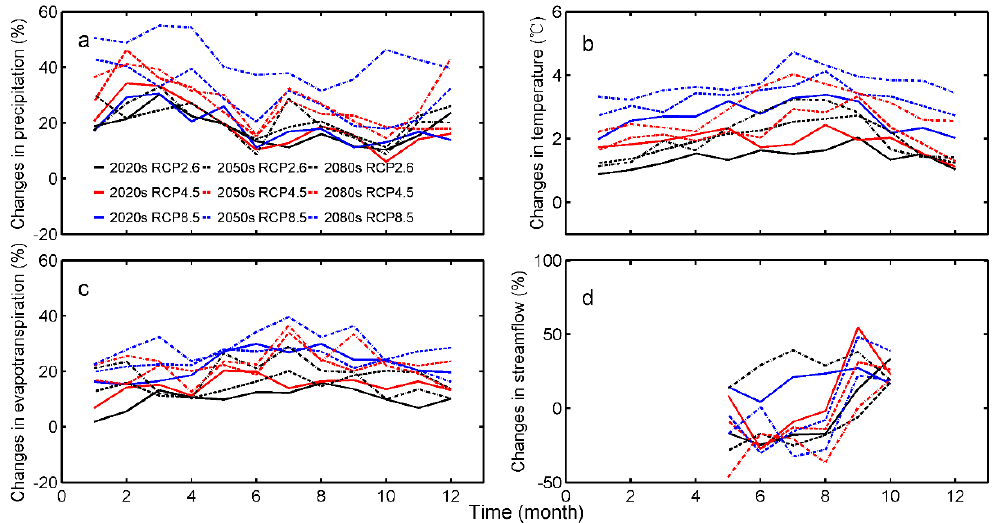
Figure 11. Changes in monthly precipitation ( a ), temperature ( b ), evapotranspiration ( c ) and streamflow ( d ) under RCPs for the future periods.